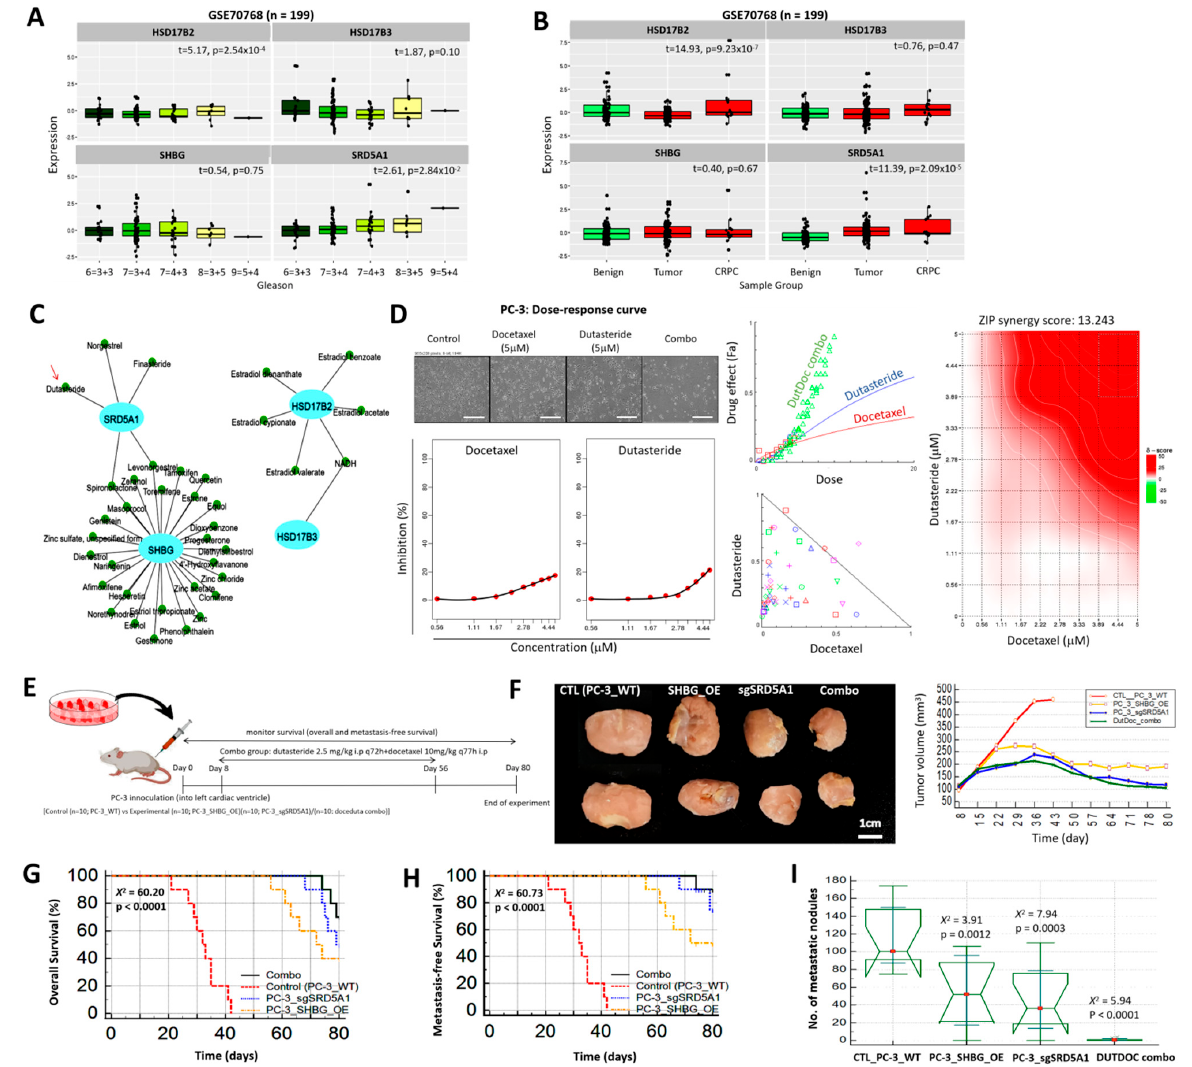
Figure 7. Inhibition of SRD5A1 with Dutasteride synergistically enhances the anticancer potential of low dose Docetaxel, reduces metastatic burden, and confers survival advantage, in vivo . Graphical representation of the correlation between HSD17B2, HSD17B3, SHBG, or SRD5A1 and ( A ) Gleason score, or ( B ) sample group in the GSE70768 PCa cohort. ( C ) Visualization of the in silico protein ‐ compound association query using the DrugBank database. ( D ) Photo ‐ images and dose–response curves showing individual and synergistic effects of Docetaxel and/or Dutasteride on the proliferation/viability of PC ‐ 3 cells. ( E ) Schema of our tumor xenograft in vivo model. ( F ) Photo ‐ image and line graph of the effect of SHBG_OE, sgSRD5A1, or docetaxel–dutasteride combination treatment on tumor volume in mice inoculated with PC ‐ 3 cells. Kaplan–Meier curves showing the effect of SHBG_OE, sgSRD5A1, or docetaxel–dutasteride combination treatment on the ( G ) overall, and ( H ) metastasis-free survival of mice inoculated with PC-3 cells. ( I ) Notched box and whiskers plot of the effect of SHBG_OE, sgSRD5A1, or docetaxel–dutasteride combination treatment on the number of metastatic nodules in mice inoculated with PC-3